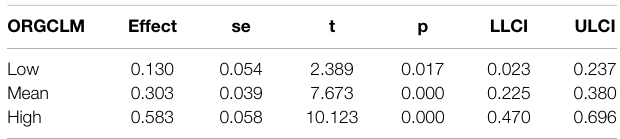
TABLE 4 | Conditional effects of the focal predictor at values of the